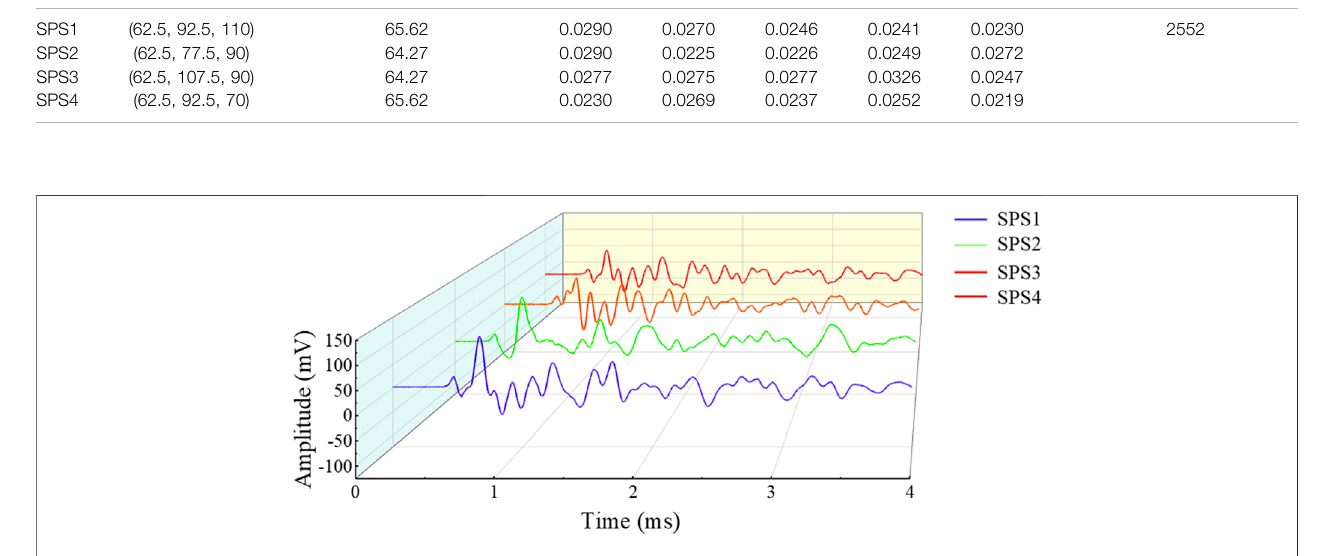
FIGURE 12 | Time-domain signals received by the CIM in test 1